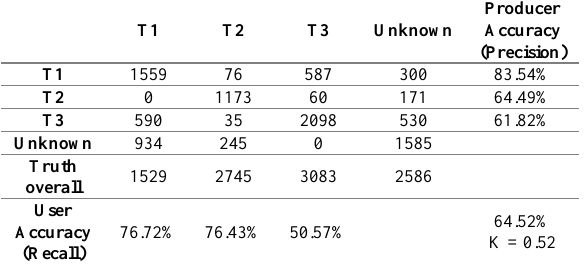
Table 2. Confusion matrix of SVM classification for Pleiades imagery.